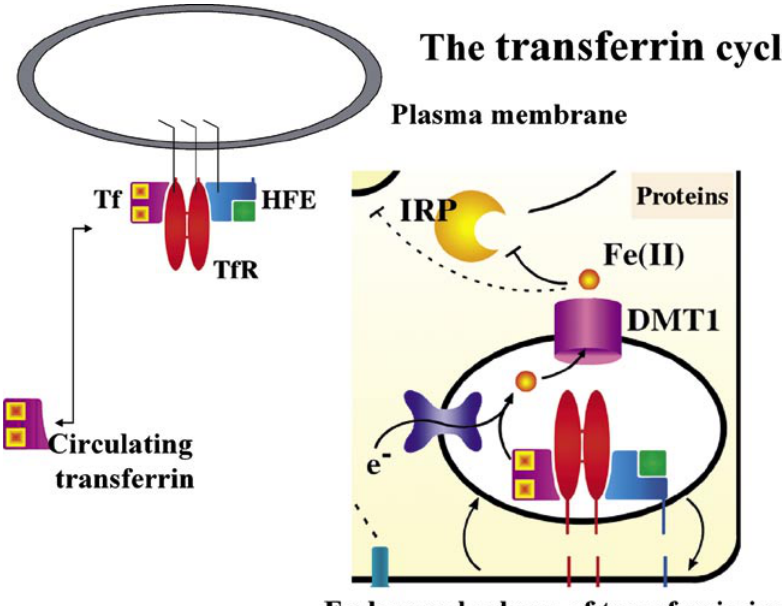
Figure 1. Binding of Transferrin Transferrin (purple rhombus) binds two ferric iron atoms (orange squares) and circulates in the bloodstream until it comes into contact with transferrin receptors, which pair together to form dimers (red torpedo shapes) on the plasma membrane surface of cells. A complex of HFE (blue square) and  2-microglobulin (green square) binds to the transferrin receptor. Notably, the binding site for HFE overlaps the potential binding site of transferrin. Since it is likely that HFE associates with transferrin receptors shortly after synthesis, before the complex arrives at the plasma membrane, HFE can thus potentially prevent iron uptake through the transferrin receptor. Once transferrin binds the transferrin receptor (assuming that both potential binding sites are not blocked by HFE), the complex internalizes in an endosome, where acidification promotes release of ferric iron, and reduction by addition of an electron (e–) to ferrous or diferric iron allows transport of free iron from the endosome, using the divalent metal transporter, DMT1, to the cytosol. Upon release into the cytosol, iron can be incorporated into proteins, and its presence can be sensed by iron regulatory proteins